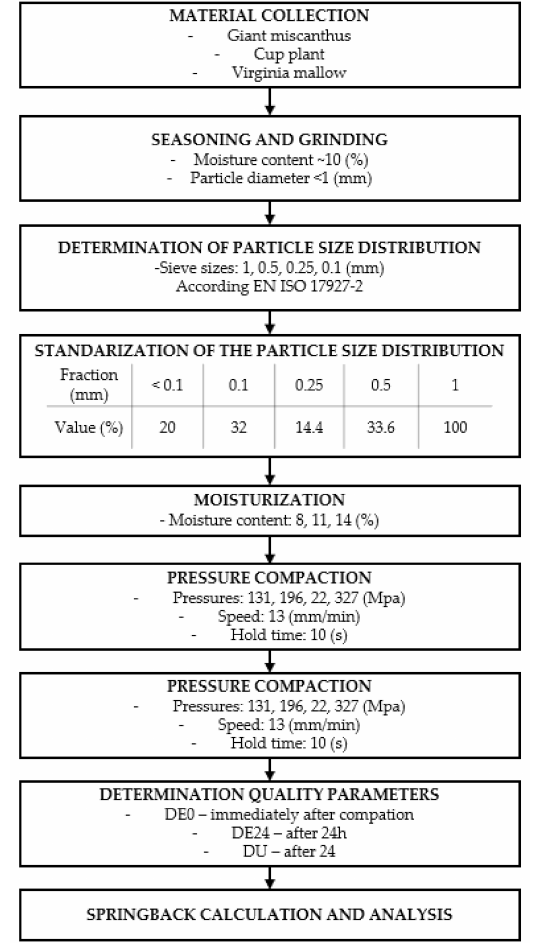
Figure 1. Diagram of research